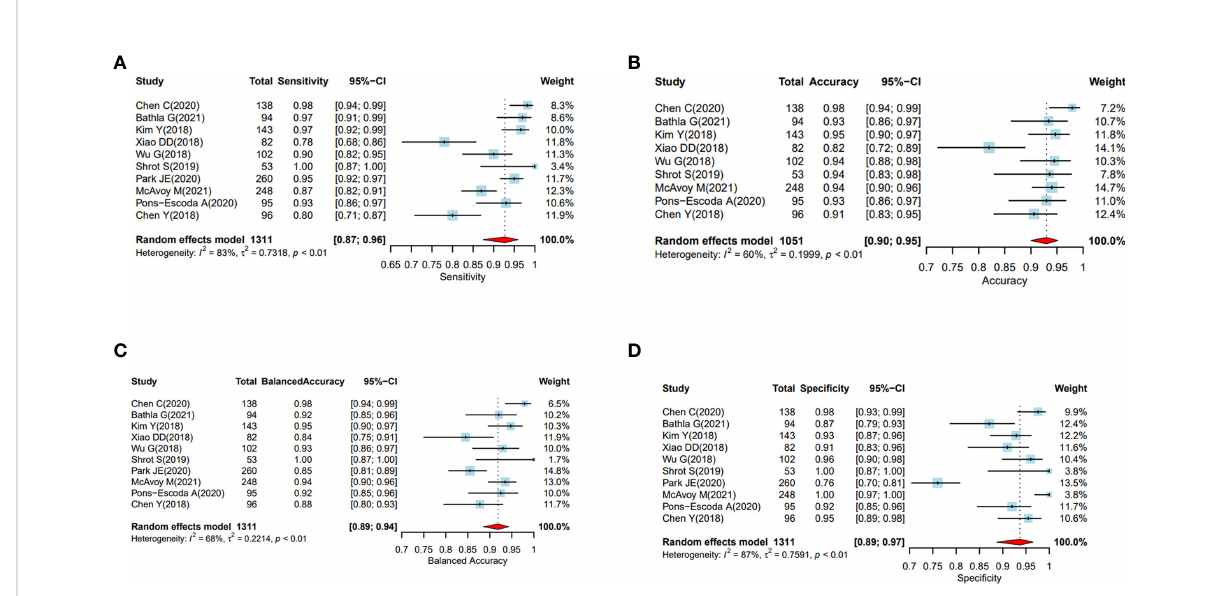
FIGURE 4 (A – D) Performance evaluation of the ML and DL algorithms of all the studies in distinguishing PCNSL from GBM as represented by the random forest plots. (A) Forest plots of sensitivity. (B) : Forest plots of accuracy. (C) Forest plot of balanced accuracy, (D) Forest plots of speci fi